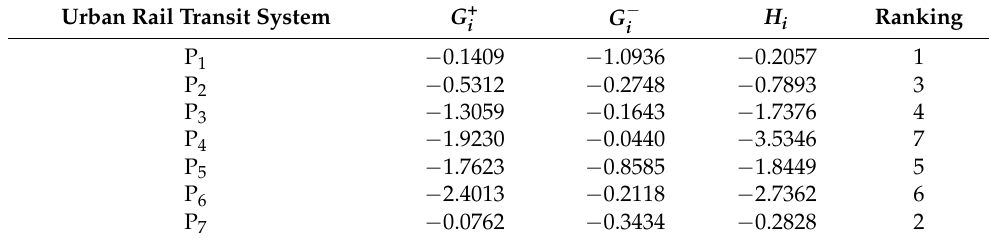
Table 11. The ranking of urban rail transit system